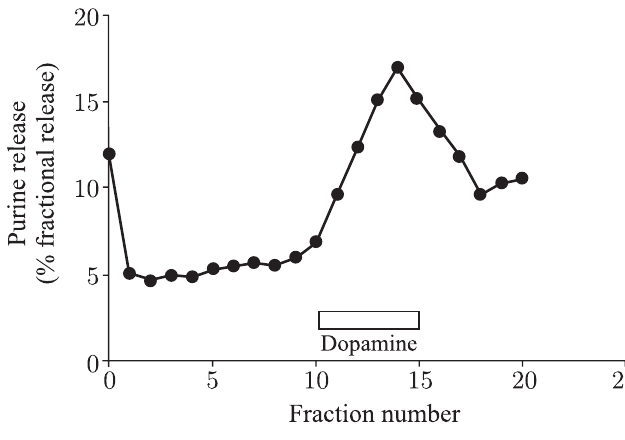
Fig. 2 – Effect of dopamine on the release of purines in cultures of chick retinal neurons. Purified retinal neuronal cultures were obtained from E8 chick embryos and incubated for 2 days. Cultures were then washed and incubated with saline containing ( 3 H)adenosine ( 0 . 2 µ M ) for 15 minutes at 37 ◦ C. After further washing cultures were successively incubated with normal saline for 10 periods of 1 minute, then incubated for 5 periods of 1 minute with saline containing dopamine ( 100 µ M ) and finally incubated for 5 periods of 1 minute with normal saline. Note the increase in purine release stimulated by dopamine and the reversibility after returning to normal